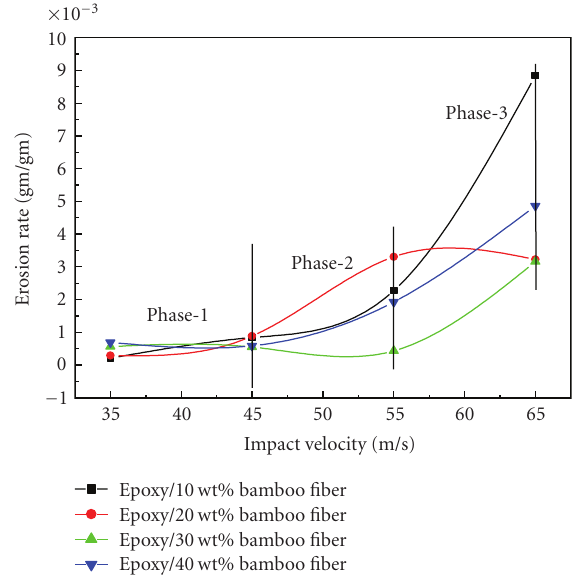
Figure 9: E ff ect of impact velocity on the erosion wear rate of the